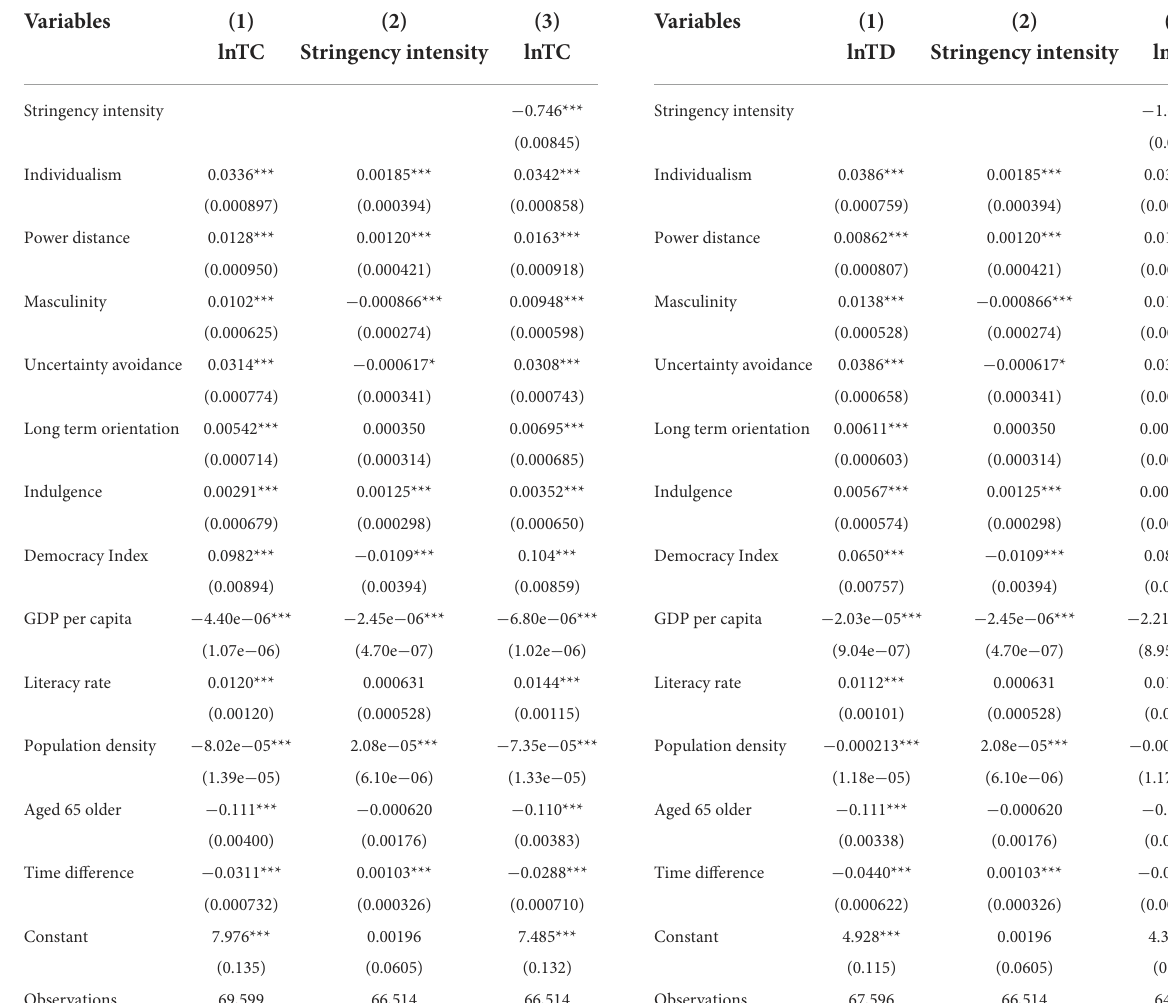
TABLE 5 Mediating effect of policy responses on total cases. TABLE 6 Mediating effects of policy responses on total